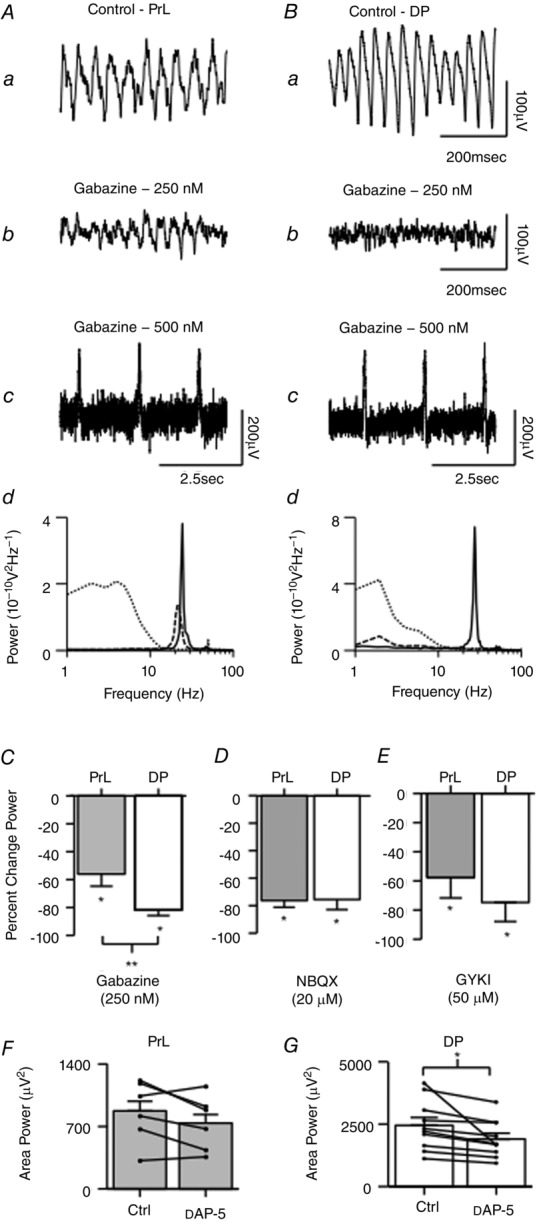
Role of GABAA, AMPA–kainate and NMDA receptor activation in the generation of fast network oscillationsTraces show 0.5 s epochs of extracellular field recordings of oscillations in PrL (A) and DP (B) in control (a; Cb–KA), following bath application of the GABAA receptor antagonist 250 nm gabazine (b), and following an increase to 500 nm gabazine (c). All oscillatory activity in both regions was abolished and slices showed burst discharges at a concentration of 500 nm gabazine. (Ad and Bd, corresponding power spectra of 60 s recordings in control (continuous line) 250 nm gabazine (dashed line) and 500 nm gabazine (dotted line). C, histogram plot of percentage change in area power shows a significant reduction in the power of the oscillations in PrL and DP at 250 nm gabazine. The reduction was significantly greater in DP compared to PrL (P < 0.05, Student's unpaired t test, nPrL = 9, nDP = 9). D, histogram plot shows percentage reduction in the power of the oscillations in PrL and DP was similar in both regions with NBQX (10 μm). E, histogram plot of percentage change in area power shows a significant reduction in the power of the oscillations in both the PrL and DP regions with 10 μm GYKI. F and G, histogram plots show area power values during control and d-AP5 conditions in PrL and DP. A significant reduction was observed only in the DP region (P < 0.05, Student's paired t test, nDP = 10). *Significant difference of area power values between control and drug conditions within each region. **Significant difference in the area power change between PrL and DP.